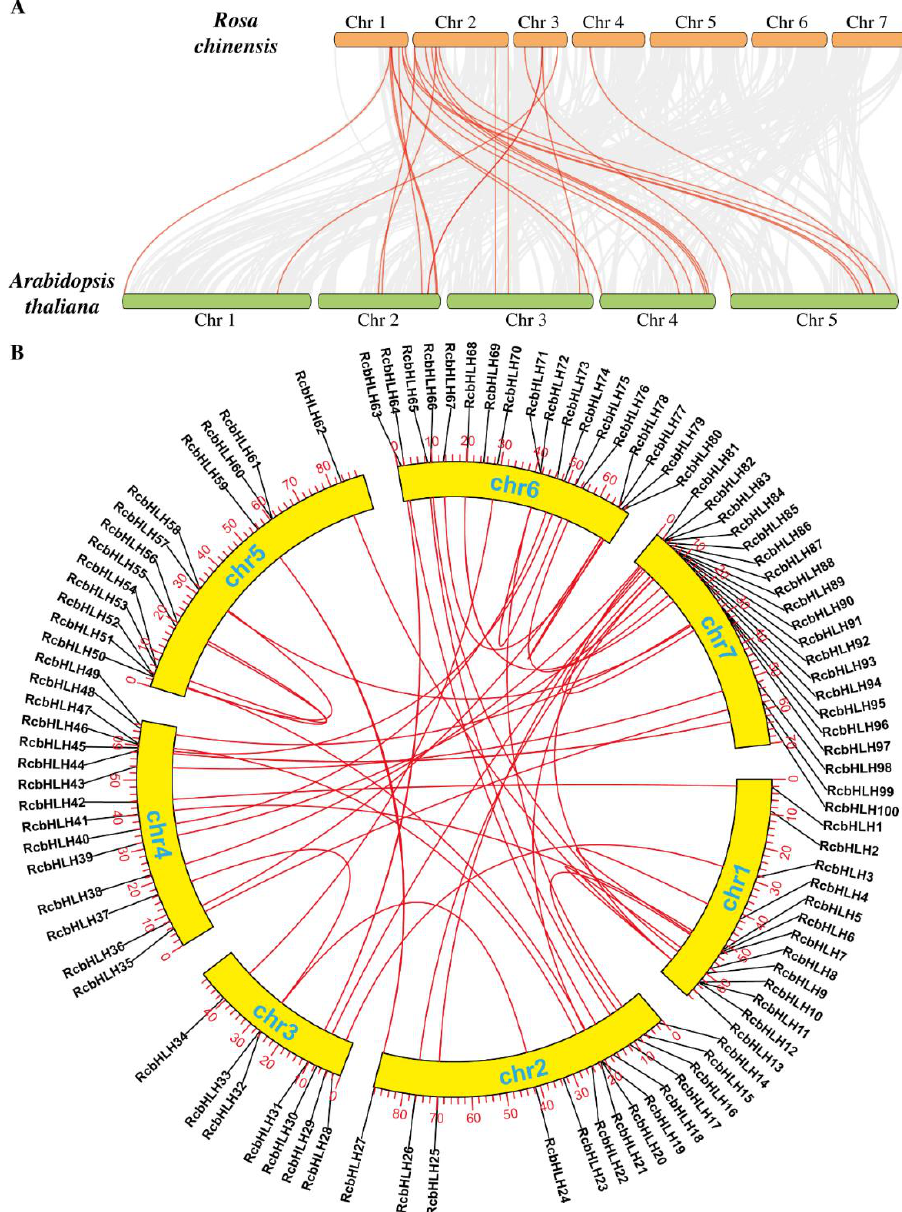
Horticulturae 2022 , 8 , x FOR PEER REVIEW Figure 6. Collinearity ( A ) and synteny analysis ( B ) of RcbHLH genes. Chr represents the chromosomes.